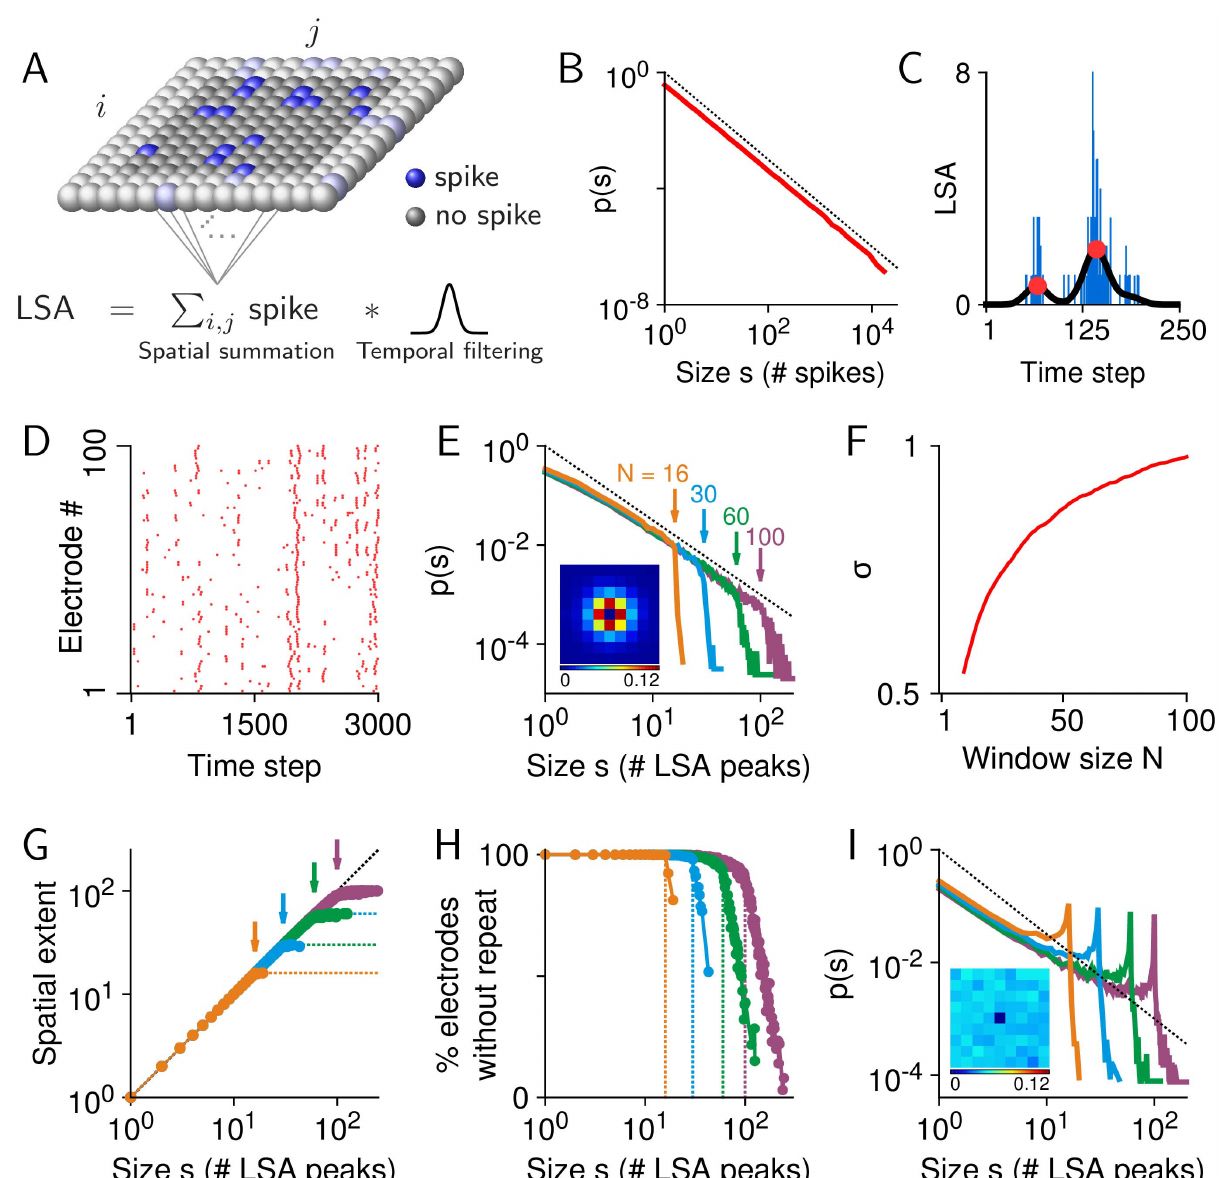
Figure 4. The two-layer model exhibits dynamics similar to LFP-based cortical neuronal avalanches. ( A ) The diagram of the model, showing a part of the two-dimensional network of binary neurons and the generation of signals at the ‘‘electrode level’’, i.e., the local spiking activity (LSA). The LSA sampled by simulated electrodes is produced by summation of spiking activities from spatially compact, non-overlapping 10 by 10 neuronal groups (dark gray and blue nodes) and subsequent temporal smoothing. ( B ) The size distribution of spike avalanches ( n =150,000; red) in the critically tuned network follows a power law with exponent 2 1.5 (dashed line). ( C ) Example trace of raw (blue) and temporally smoothed (black) LSA activities (half-width of the Gaussian smoothing window: 30 time steps). LSA peaks (red dots) were detected by applying a threshold of LSA=0.1. ( D ) Raster of LSA peaks detected at the electrode level (individual dots represent LSA peaks). ( E ) Avalanche size distributions observed at the electrode level of the model with local connectivity are plotted for four different observation windows ( n =50,105 avalanches for N =100). Inset: probability of LSA propagation across the two-dimensional array of simulated electrodes. The positions of arrows indicate the corresponding window sizes. The dotted line is a power law with exponent of 2 1.5. ( F ) The estimated branching parameter, s , is plotted against the observation window size N . ( G ) The average spatial extent, quantified by the number of unique electrodes involved in an avalanche, is plotted against avalanche size for different observation windows. The horizontal dotted lines indicate window sizes (same as E ). The diagonal dotted line indicates equality. ( H ) Percentage of electrodes without repeated activation during an avalanche is plotted as a function of avalanche size. ( I ) The same as in E for all-to-all connectivity (inset shows the probability of LSA propagation across the electrodes).